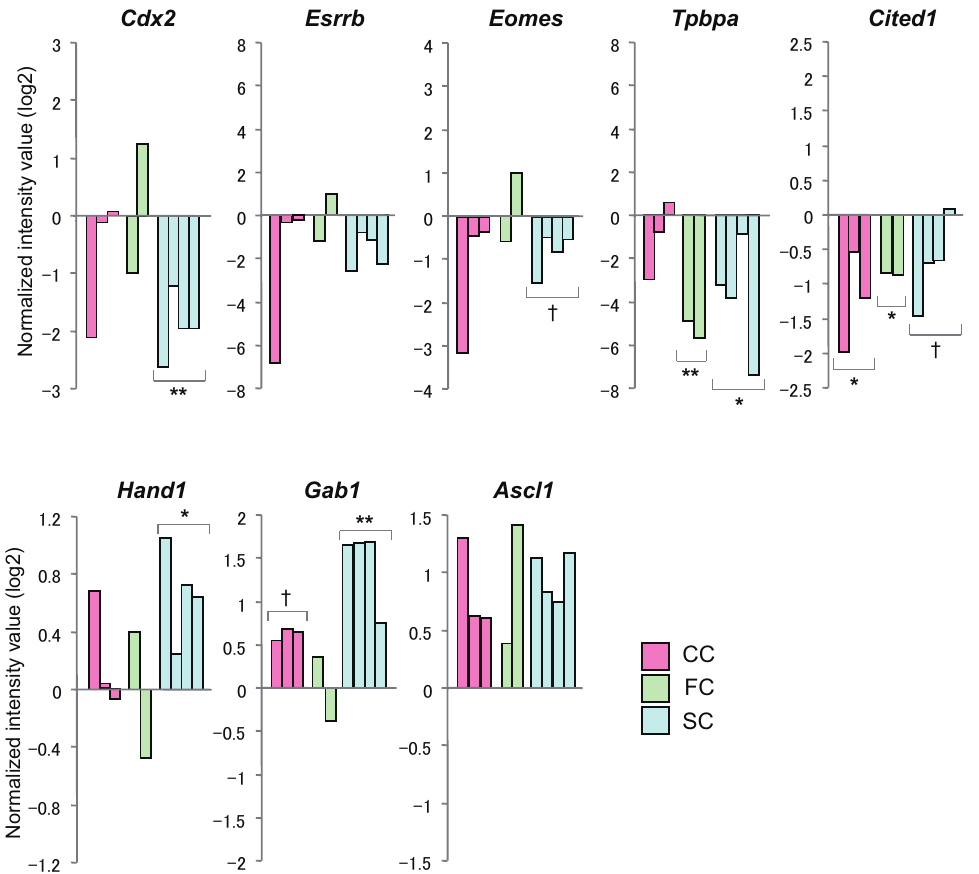
Figure 6. Expression levels of genes important for early placentation. Genes important for maintenance of undifferentiated trophoblast cells ( Cdx2 , Esrrb and Eomes ) were downregulated while those essential for differentiation into giant cells ( Hand1 ) were upregulated. * P , 0.05, ** P , 0.01 (compared with the corresponding IVF-derived controls). ‘‘ { ’’ indicates a tendency for down- or upregulation, but not with a statistical significance ( P ,